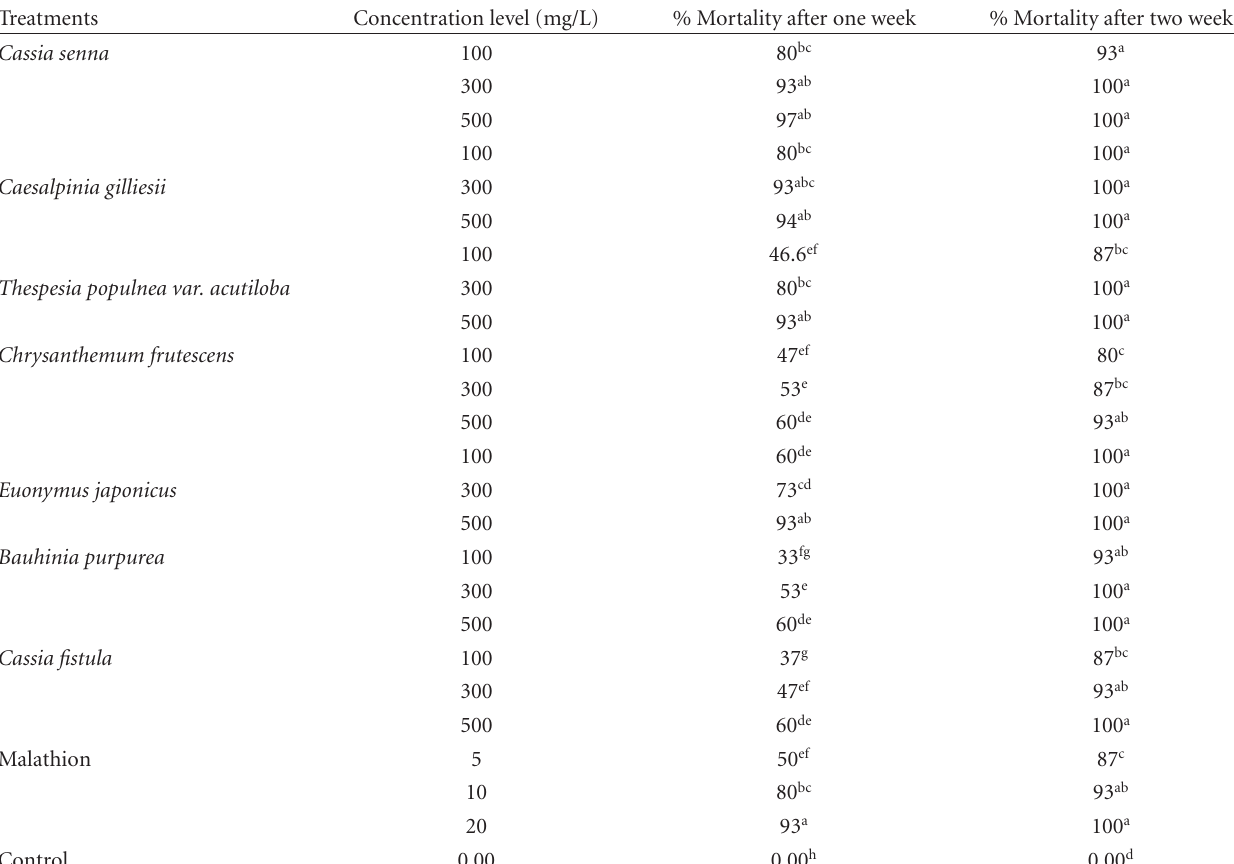
Table 4: E ff ect of tested plant extracts and malathion on mortality of T. granarium larvae.